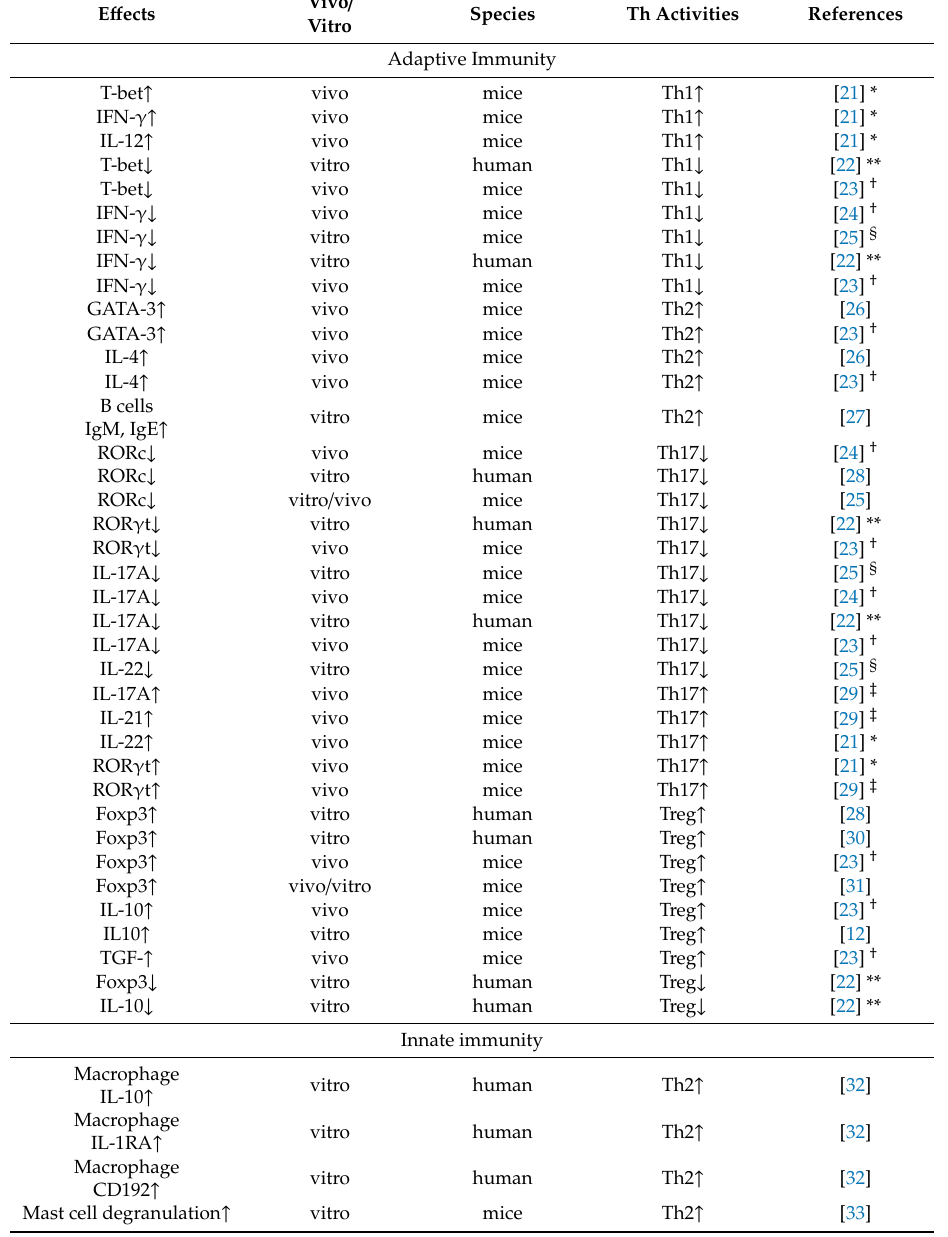
Mast cell degranulation ↑ vitro mice Th2 ↑ [33] ↑ , stimulation; ↓ , suppression; ROR, retinoic acid receptor-related orphan nuclear receptor; Foxp3, forkhead box P3; GATA3, GATA binding protein 3; T-bet, T-box-containing protein expressed in T cells; STAT3, signal transducer and activator of transcription 3; *, Estrous level of estradiol (E2) induced the e ff ects, pregnancy-level of E2 did not; **, E ff ects of polyphenolic compound delphinidin; † , Pregnancy-levels of E2; ‡ , Estrogen receptor agonist diarylpropionitrile; §, 10 − 10 M E2 induced the e ff ects, but 10 − 11 E2 did not; E ff ects of selective estrogen receptor